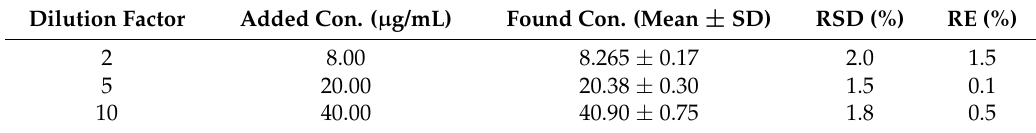
Table 5. Sample dilution accuracy and precision of the assay for CMME in Beagle dog plasma ( n = 5). Dilution Factor Added Con. ( µ